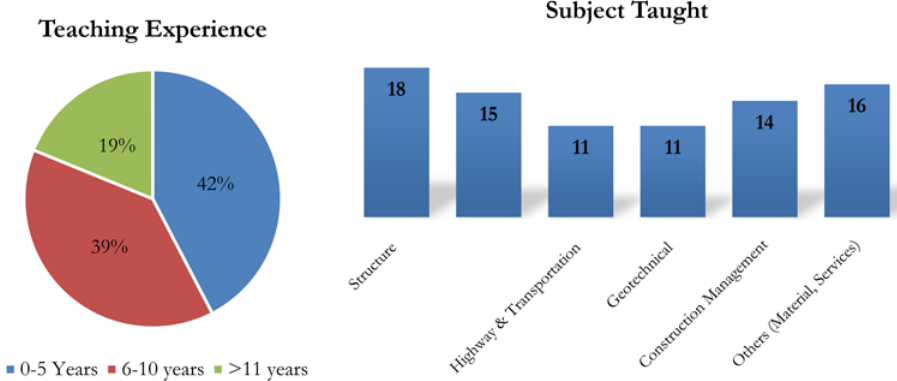
Figure 2 Teaching profile of respondents